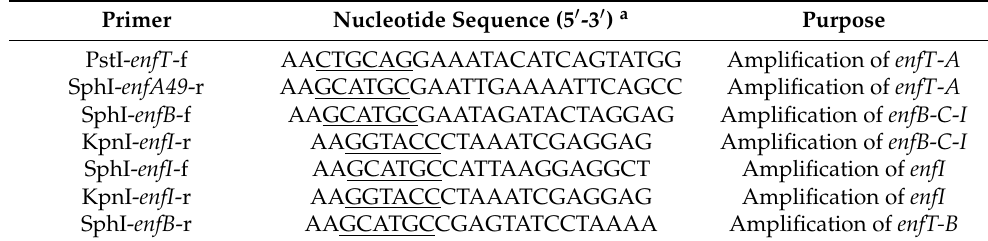
Table 2. Primers used in this